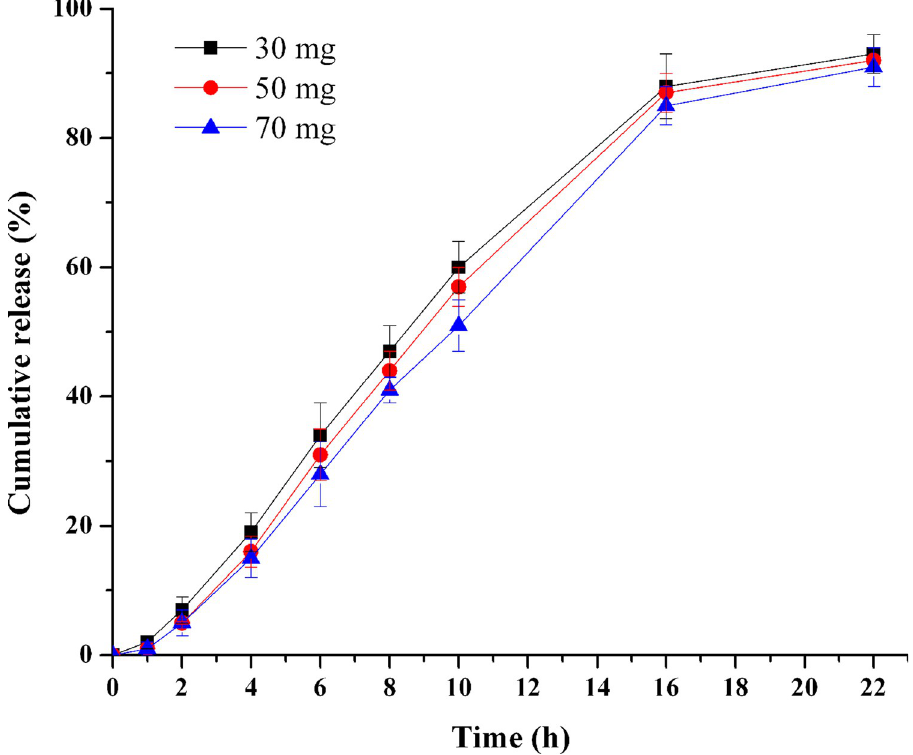
Fig 5. Effect of drug loading on TPM release (n =